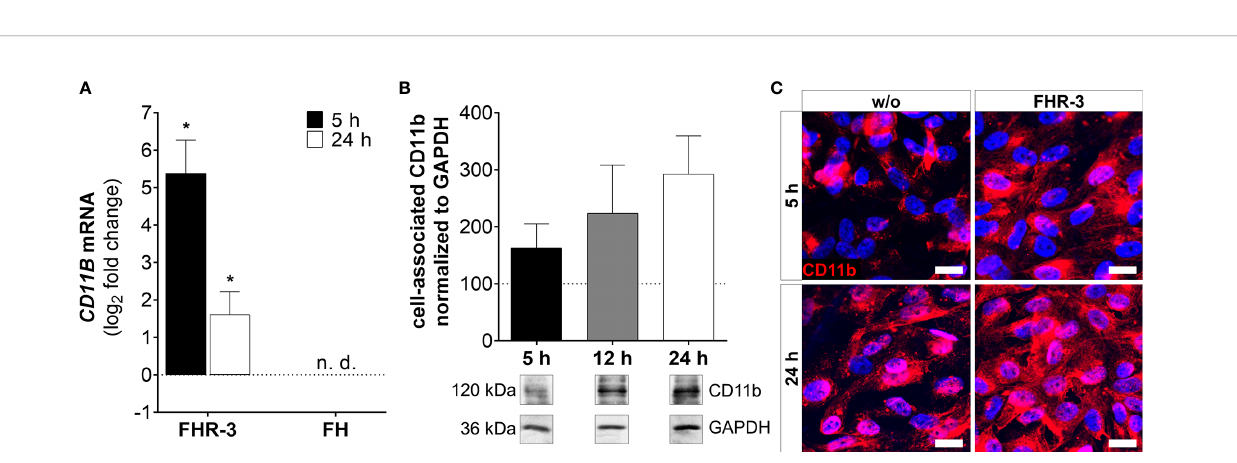
FIGURE 7 | CD11b expression was highly elevated in FHR-3 treated ARPE-19 cells. (A) CD11B mRNA expression was highly elevated after 5 h and 24 h FHR-3 incubation. No expression of CD11B mRNA could be detected when cells were treated with FH. The effect of FHR-3 could be con fi rmed at the protein level: (B) Western blots of ARPE-19 cell lysates showed a time-dependent increase in CD11b levels (120 kDa) from 5 h – 24 h after FHR-3 incubation. Supplementary Figure 1N shows full Western blots. (C) Elevated CD11b protein levels were detected by immuno fl uorescence using a speci fi c anti-CD11b antibody (red) after 5 h and 24 h of FHR-3 incubation (right panels). Scale bars 40 µm. w/o untreated control (dotted line). n.d. not detected. Mean with standard deviation is shown. *p < 0.05. (A) Wilcoxon matched-pairs signed rank test (n = 3); (B) Ordinary one-way ANOVA, Turkey ’ s multiple comparisons test (n =